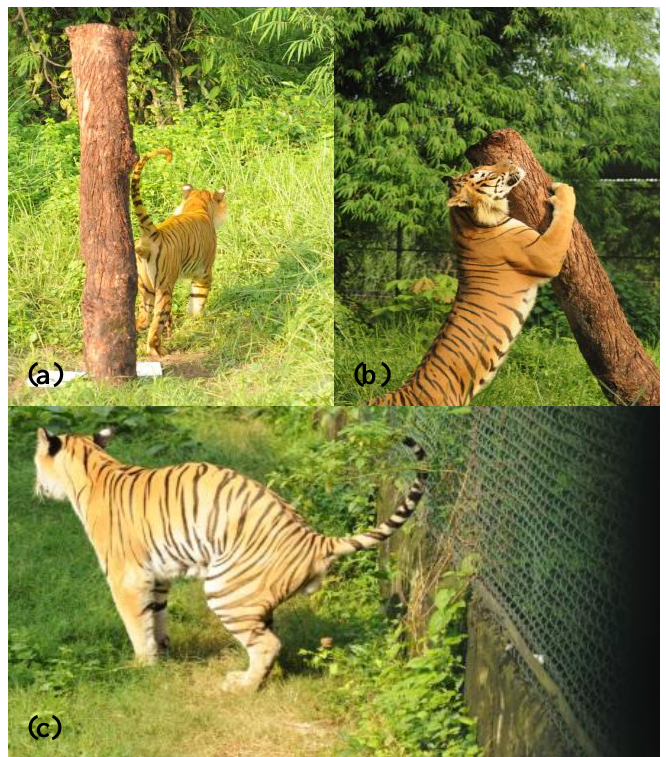
Figure 1. A Bengal tiger ( Panthera tigris tigris ) performing a variety of scent-marking behaviors in its outdoor enclosure at Khayebari Tiger Rehabilitation Project: ( a ) releasing marking fluid; ( b ) clawing/scratching ( c )